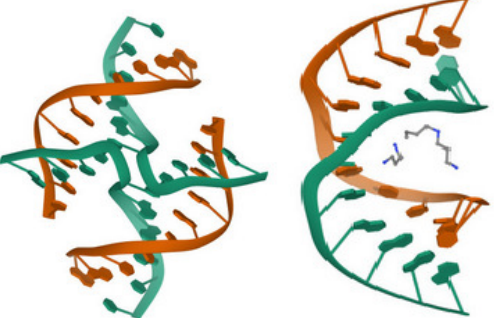
Figure 5. ( Left ) The four-strand Holliday junction J : PDB 1 ZF 2, ( Right ) A complete turn of A- DNA: PDB 2 D 47. It is associated to DNA dodecamer sequence d ( CCCCCGCGGGGG ) with SL ( 2, C ) containing the factor f H = xyz − x 2 − y 2 − z 2 + 4 (the Cayley cubic) and the factor f ˜ 2 x 2 + 2 y 2 − 3 z 2 −